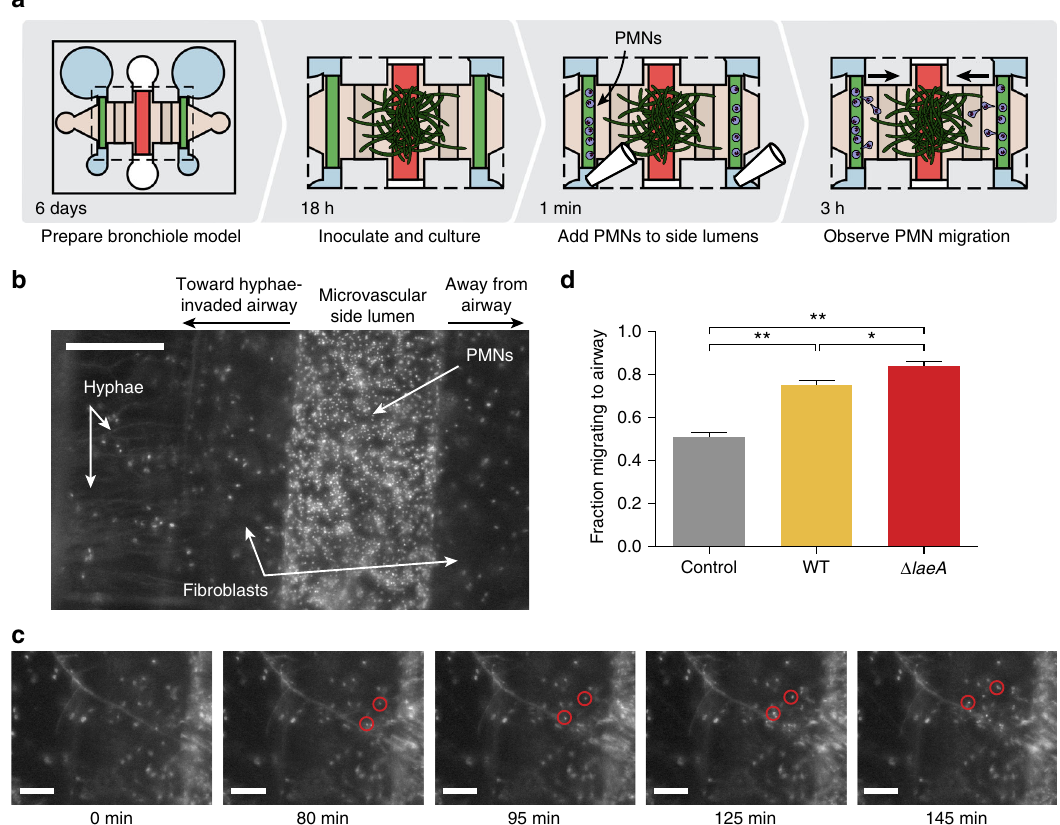
Fig. 3 Polymorphonuclear leukocytes (PMNs) preferentially migrate toward fungal hyphae. a Diagram of the experimental setup. Fungal hyphae extend from the center, epithelial cell-lined lumen 18 h after inoculation with WT or Δ laeA A . fumigatus spores at which point PMNs puri fi ed from whole blood are added to side, endothelial-lined lumens and migration is observed. b Magni fi ed image of one side lumen fi lled with PMNs, all cells stained with Hoechst (nuclear stain). Scale bar is 200 μ m. c Time lapse frames tracking two PMNs (red circles) as they leave the side lumen and migrate toward the hyphae extending from the center airway. Frame time is given in minutes, and the scale bars are 100 μ m. d The fraction of PMNs that extravasated from the airway-facing side of the endothelial lumens and migrated in the direction of the center, hyphae-invaded airway lumen, compared with those that extravasated and migrated in the opposite direction. Each plotted bar represents the mean of nine organotypic devices prepared on three separate days, with fractions calculated as the average of both endothelial side lumens per device. Error bars represent standard error of the mean. Data were analyzed using an ordinary one-way ANOVA with Tukey ’ s multiple comparisons test: *denotes p -value < 0.05 and **denotes p -value <